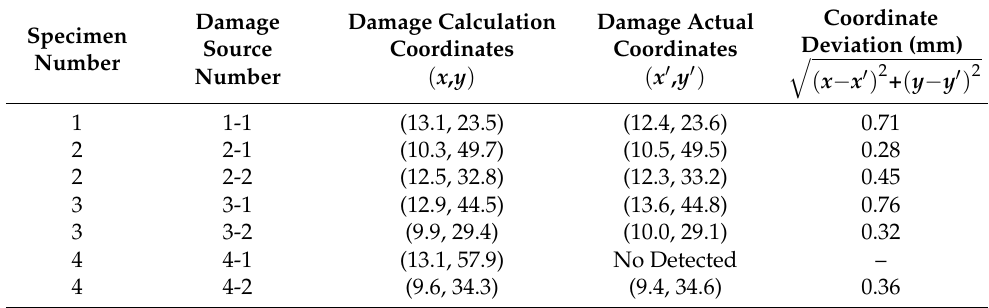
Table 2. Comparison of the measured damage location coordinate and the actual one.